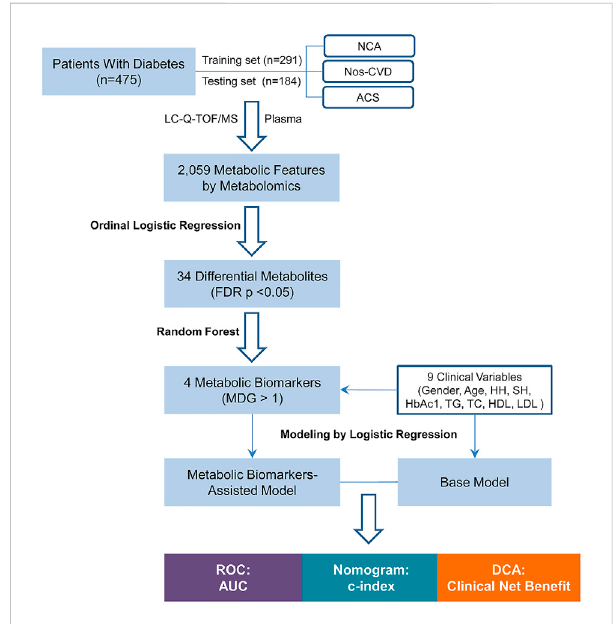
FIGURE 1 Flow Chart of the study. NCA = normal coronary artery; Nos- CVDs = non-signi fi cant cardiovascular diseases; ACS = acute coronary syndrome; LC-Q-TOF/MS = liquid chromatography- quadrupole time-of- fl ight mass spectrometry; FDR = false discovery rate; MDG = mean decrease gini; HH = hypertension history; SH = smoking history; HbA1c = glycosylated hemoglobin; TG = triglyceride; TC = total cholesterol; HDL = high-density lipoprotein cholesterol; LDL = low-density lipoprotein cholesterol; ROC = receiver operating characteristic; AUC = area under the curve; c-index = concordance index; DCA = decision curve